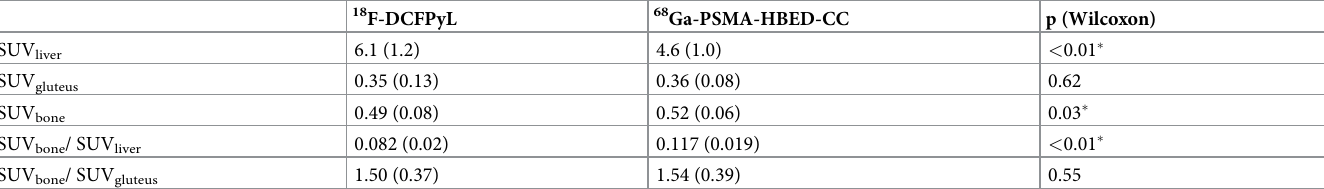
Table 1. Quantitative results in bone negative group. Average values and standard